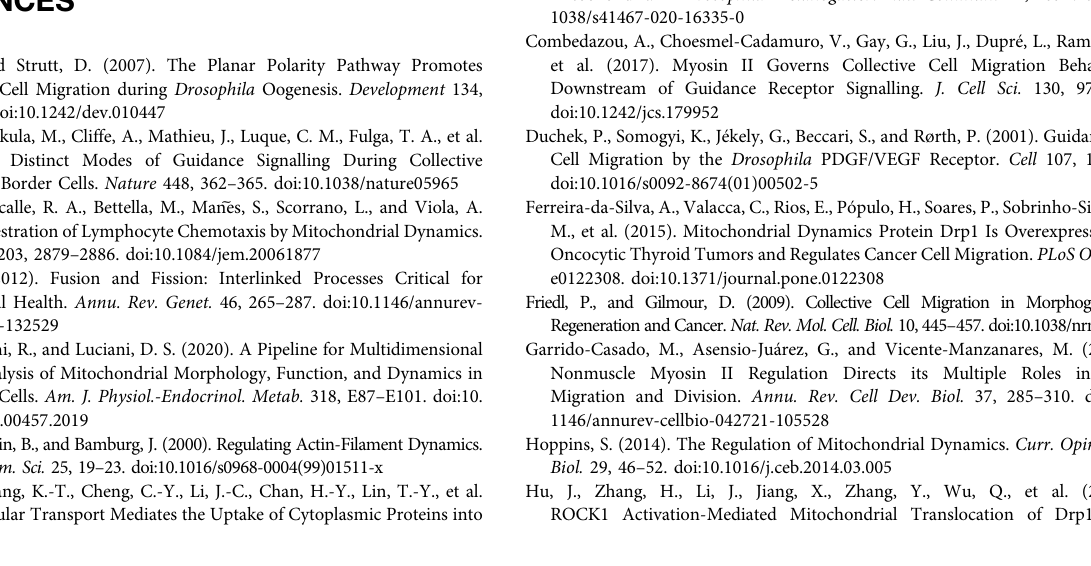
Supplementary Figure S5 | (A) Confocal images showing border cell cluster expressing Drp1 RNAi, Mfn (Mfn OE) and Drp1 (Drp1 OE) by the slbo-Gal4. (B) The protrusionlength ismeasuredasthe distance between the tip ofthe protrusionto the periphery ofthe cluster aspreviouslydescribed (Zhang etal, 2011),actin-enriched protrusionishighlighted byrhodamine-phalloidin,whichstainsF-actin(red) inthe fi xed samples. DAPI stains the nuclei (blue). Drp1 RNAi, Mfn OE and Drp1 OE border cell clusters have signi fi cantly shorter leading protrusions than the wildtype control. Scale bars: 10 mm. Error bars indicate S.D. **p < 0.01, ***p < 0.001. n.s., not signi fi cant. Supplementary Figure S6 | (A) Confocal images showing follicle cells expressing RhoAV14 andROCK.CAT bytheGR1-Gal4. AnincreaseofF-actininthecellcortex